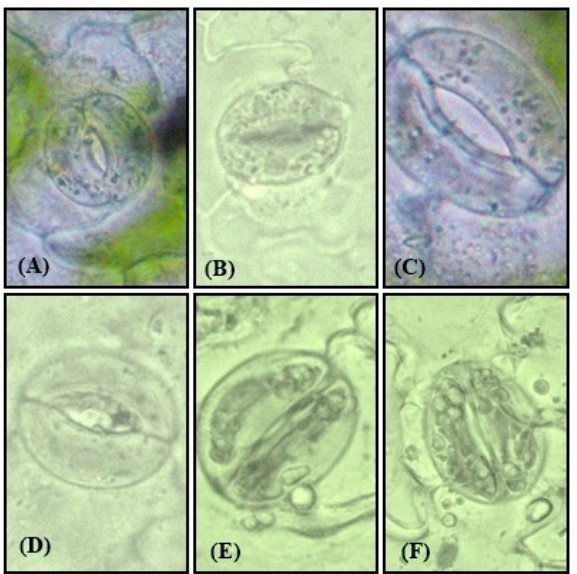
Figure 12. Stomatal response of Indian mustard ( Brassica juncea L.) leaves at 30 DAG under control ( A ), Cu ( B ), SNP ( C ), SNP + Cu ( D ), FCy + Cu ( E ) and SNP + Cu + cPTIO ( F ) at 40 × using compound microscope.